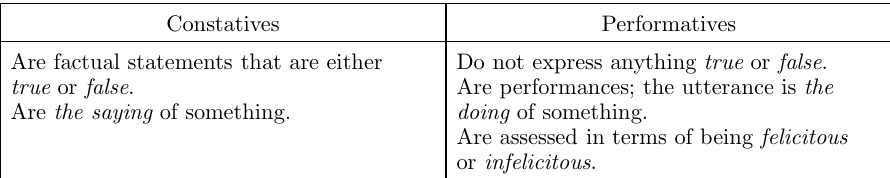
Distinction between constatives and performatives Constatives